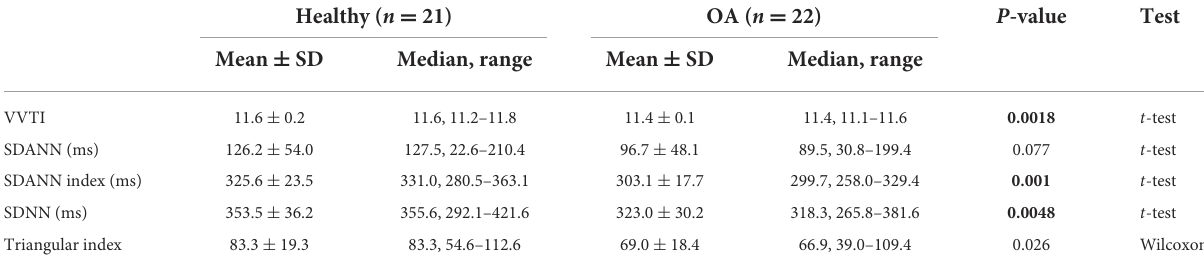
TABLE 6 Heart rate variability parameter